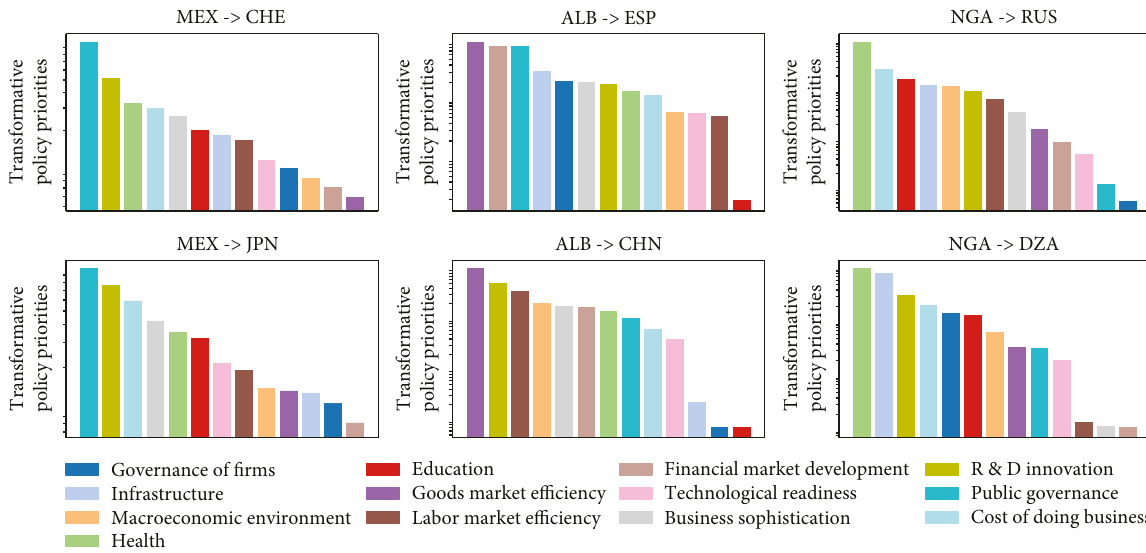
Figure 2: Average allocation pro fi les of three country cases.